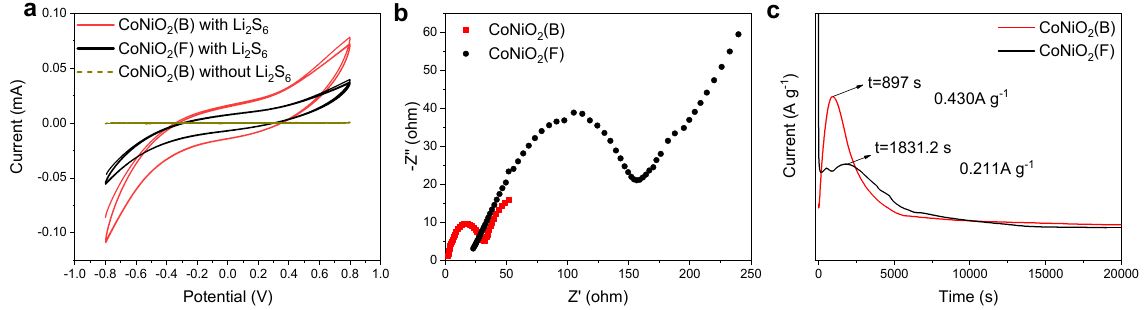
Figure 5. Electrochemical Performance of Symmetric Battery; ( a ) CV cycle curves and ( b ) EIS curves of CoNiO 2 (B) and CoNiO 2 (F) symmetric cells. ( c ) Li 2 S deposition profiles on CoNiO 2 (B) and CoNiO 2 (F).